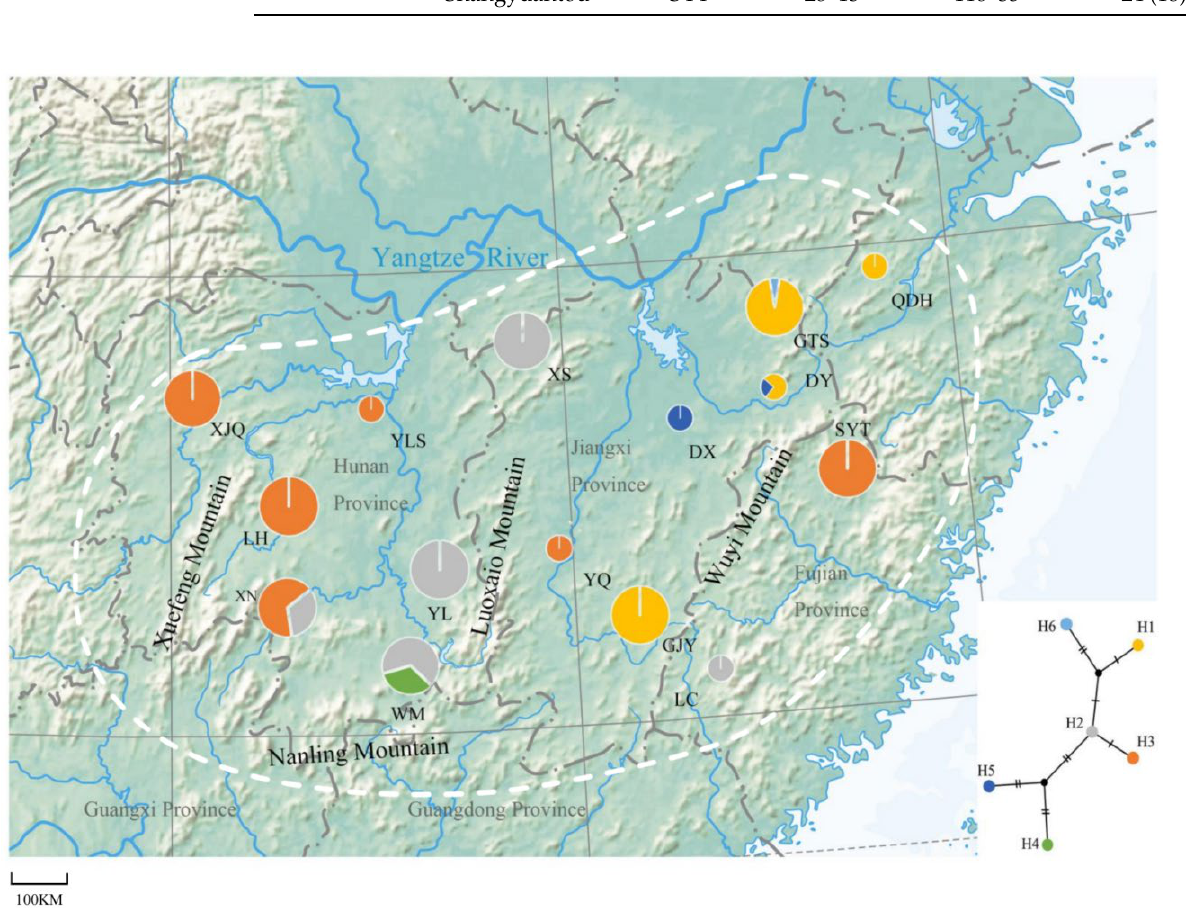
Figure 1. Locations and haplotypes distribution of sampled populations of Castanopsis sclerophylla . Circle size is proportional to the number of individuals sequenced. The dashed white line shows the current distribution range of Castanopsis sclerophylla . The inset at the lower right corner shows the relationships among haplotypes.